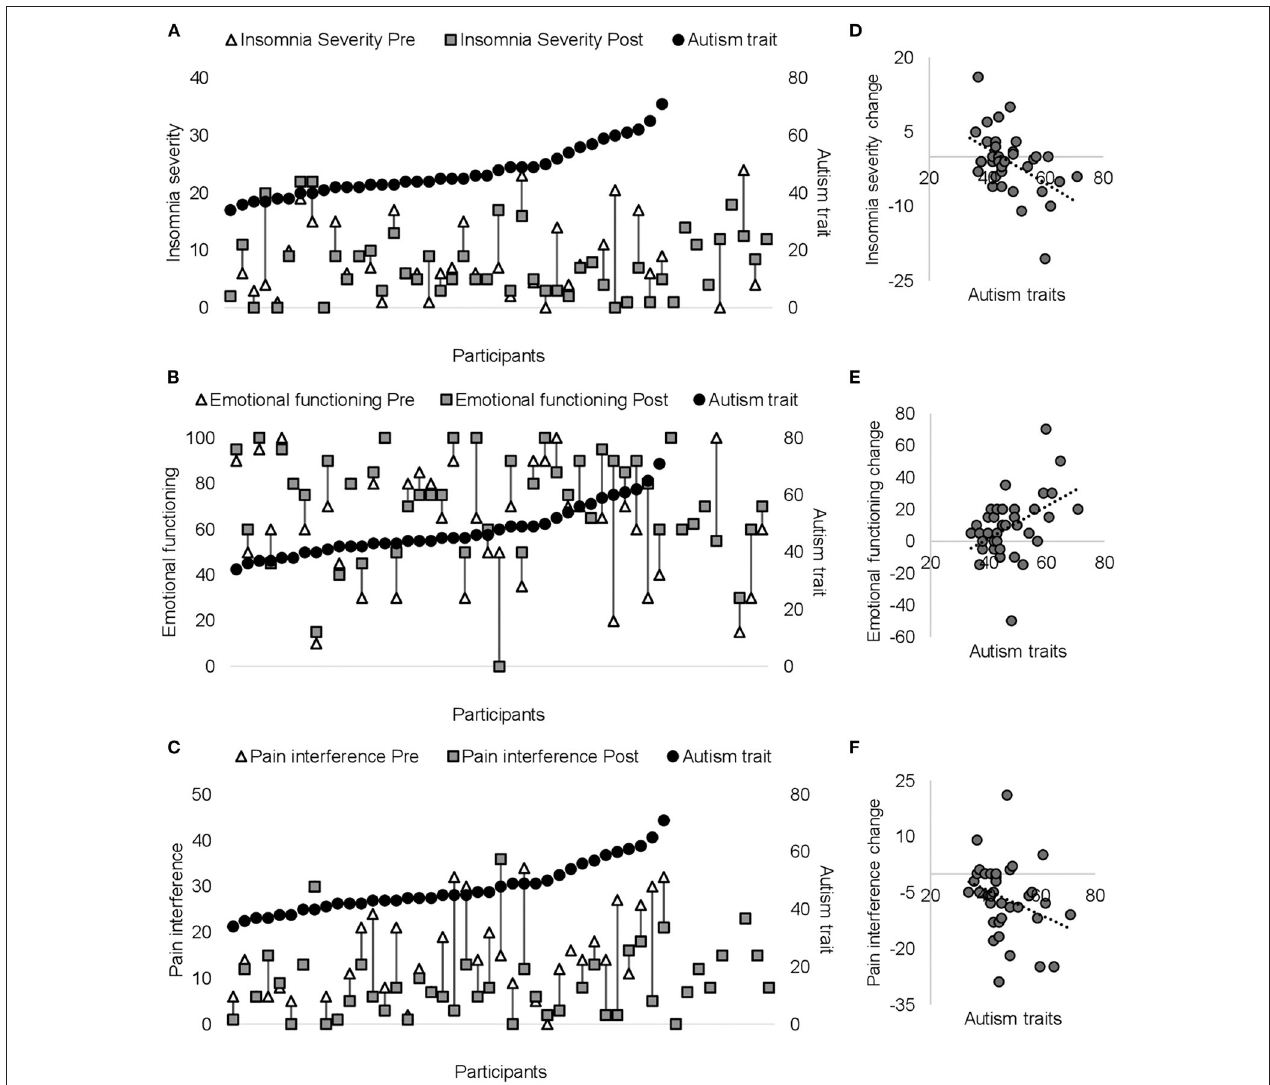
FIGURE 3 | Pre- (white triangles) and post-ACT scores (dark gray squares) are plotted on the primary (left) y -axis for each patient for insomnia (A) , emotional functioning (B) , and pain interference (C) . Black circles on secondary y -axis represent individual autism scores (presented from the lowest to the highest score). The right panel (D–F) shows significant correlations between autism traits and change score (from pre- to post-ACT) for insomnia (D) emotional functioning (E) , and pain interference (F) . Negative insomnia severity/pain interference change scores indicate greater improvements in insomnia/pain interference. Positive emotional functioning change scores indicate greater improvements in emotional